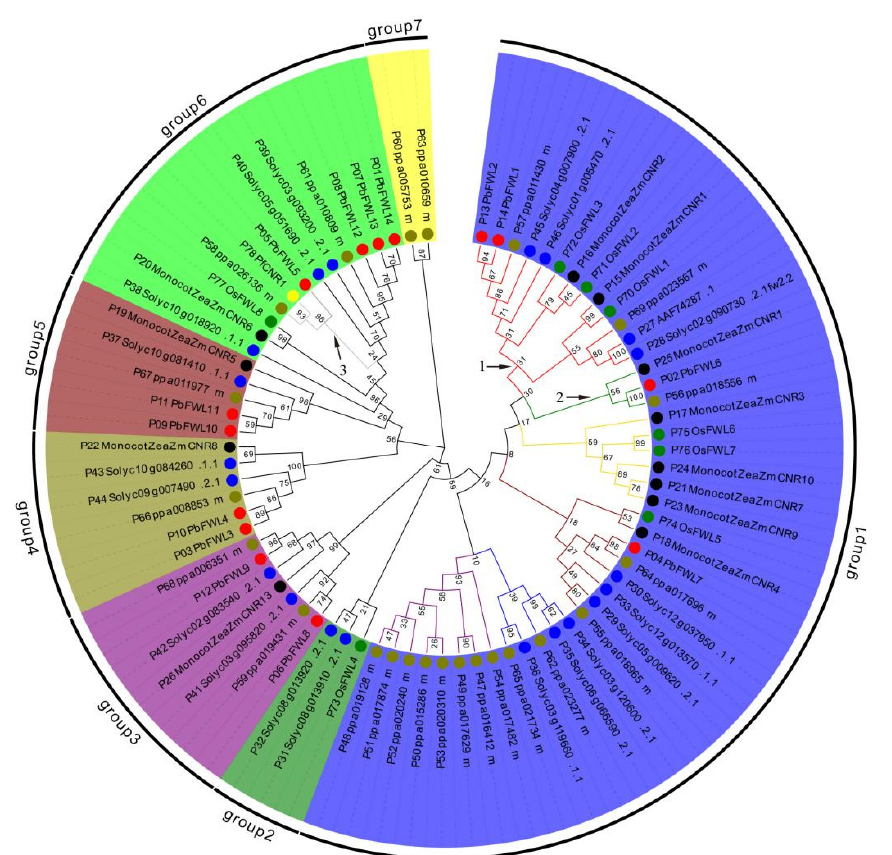
Figure 2. Phylogenetic tree analysis of fw2.2/CNR proteins in pear and other plants. The solid red circles represent pears, the solid black circles represent corn, the solid blue circles represent tomatoes, the solid olive circles represent peaches, and the solid green circles represent rice.